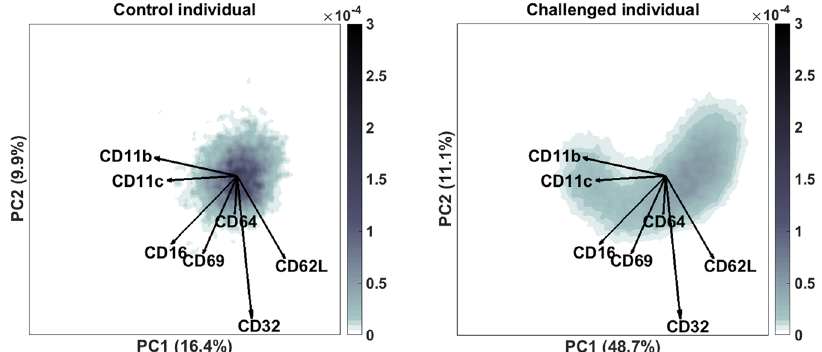
Figure 2. Smoothed histograms of the biplots shown in Fig. 1 of a typical control (left) and a typical LPS- responding individual (right). The darker bin, the more cells are likely present in that location. The same loadings are plotted on top as vectors and indicate how each surface marker contributes to the cell variability in a specific